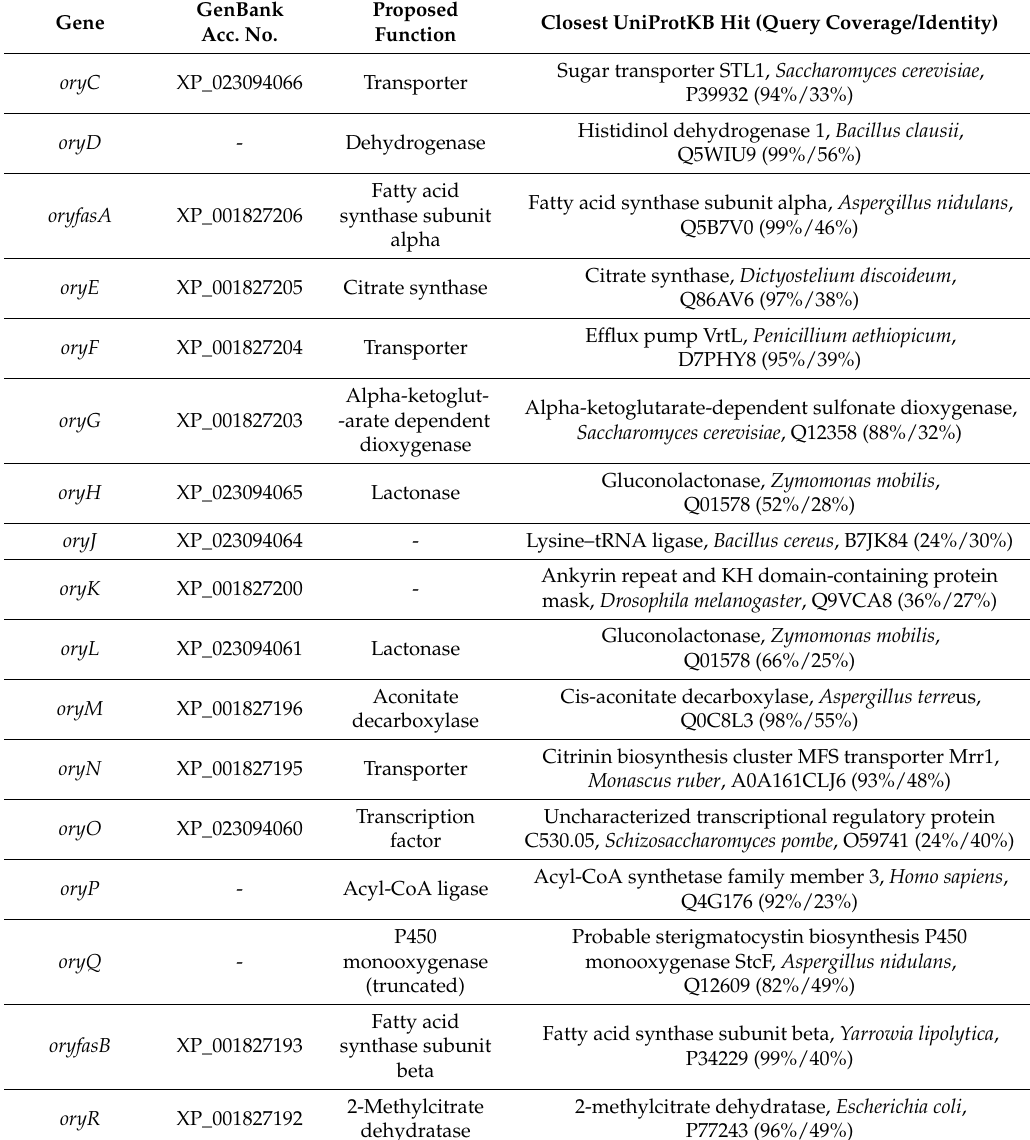
Table 1. Predicted genes of the oryzine BGC and their proposed